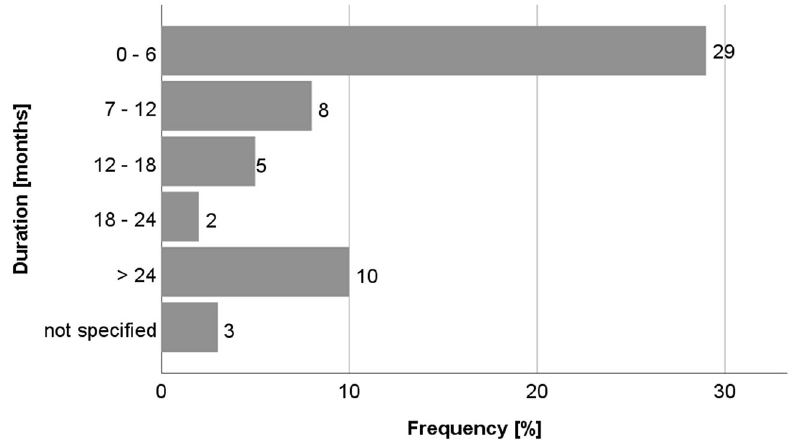
Figure 2. Time to diagnosis in Austrian patients.